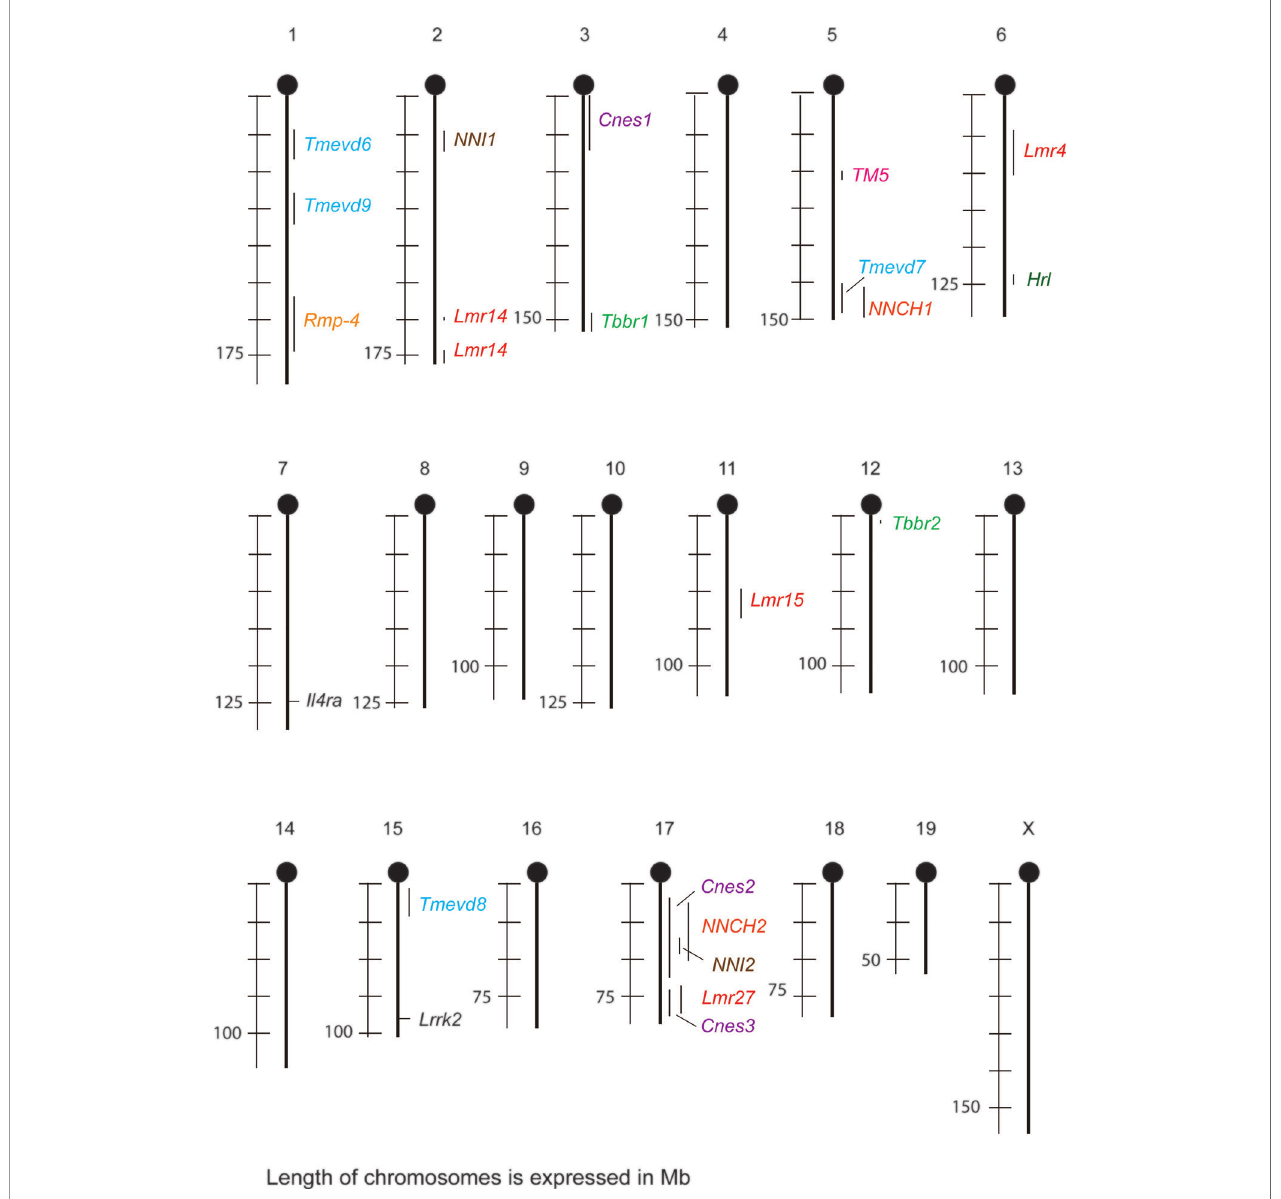
FIGURE 1 | Sex-dependent loci and genes that control susceptibility to infections in mouse and their overlaps. Cnes , Cryptococcus neoformans susceptibility; Hlr , herpes resistance locus; Il4ra , interleukin 4 receptor alpha; Lmr , Leishmania major response; Lrrk2 , leucine-rich repeat kinase-2; NNCH , not named Chlamydia ; NNI , not named in fl uenza; Rmp-4 , Resistance mousepox 4; Tbbr , Trypanosoma brucei brucei response; TM , Trichuris muris ; Tmevd , Theiler ’ s murine encephalomyelitis virus-induced